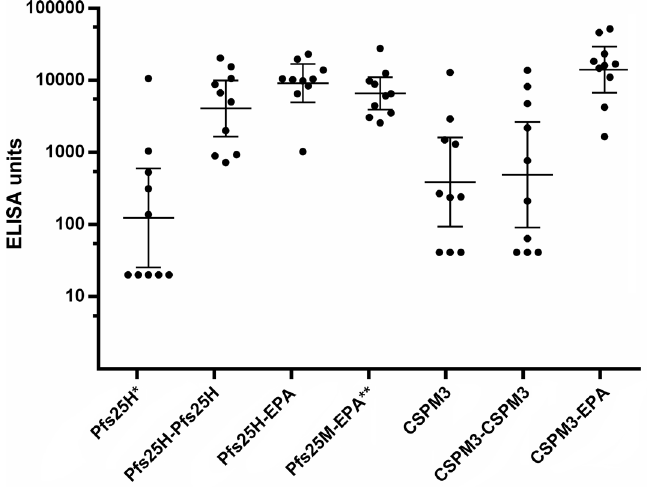
Fig 5. Antibody levels in mice vaccinated with un-conjugated or conjugated forms of Pfs25H, Pfs25M, and CSPM3, expressed as ELISA units (dilution sera to obtain an OD of 1). Mice were injected IM twice, 28 days apart, with 0.5 μ g antigen content ( * 2.5 μ g for Pfs25H) of the vaccines adsorbed on 80 μ g of Alhydrogel ( ** 45 μ g of Alhydrogel for Pfs25M-EPA). Serum antibody levels were determined two weeks later by ELISA on plates coated with un-modified antigen. Dots represent ELISA units reported for individual mice. Center line represents the geometric mean, and error bars are 95% confidence levels. Statistics (Kruskal-Wallis with Dunn ’ s multiple comparisons): p < 0.05 for Pfs25H-EPA vs. Pfs25H; CSPM3-EPA vs. CSPM3- CSPM3; CSPM3-EPA vs. CSPM3.